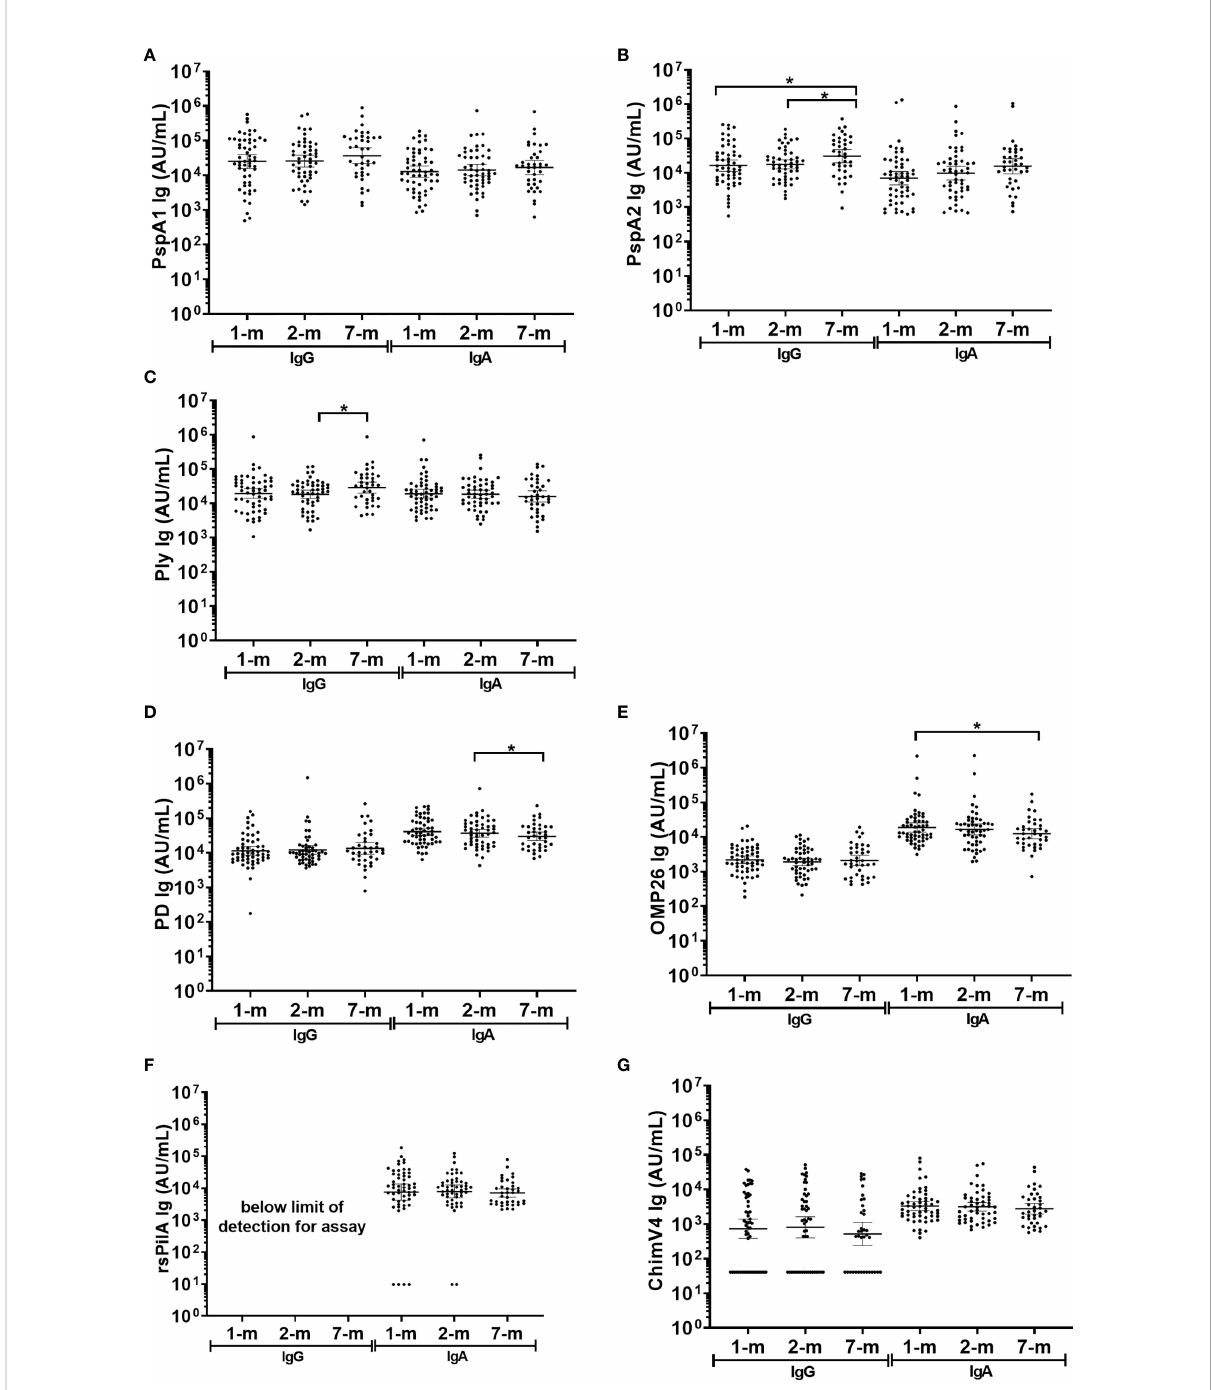
FIGURE 5 Breast milk IgG and IgA titres against Streptococcus pneumoniae and Haemophilus in fl uenzae antigens. Each point represents the breast milk IgG and IgA titres against S. pneumoniae antigens (A) PspA1, (B) PspA2, (C) Ply and H. in fl uenzae antigens (D) PD, (E) OMP26, (F) rsPilA and (G) ChimV4. PspA1, pneumococcal surface protein A family 1; PspA2, pneumococcal surface protein A family 2; Ply, pneumolysin. PD, Protein D; OMP26, outer membrane protein 26; rsPilA, recombinant soluble pilus A protein; ChimV4, chimeric vaccine antigen 4 (rsPilA and P5). * p-value <0.05, paired t-tested were conducted on the logarithmically transformed data. 1-month n=55, 2-months n=51, 7-months n=38. All samples had measurable antibody titres except for rsPilA, for which 6 samples were below the limit of detection for anti-rsPilA IgA. The assay reference breast milk had minimal rsPilA IgG therefore anti-rsPilA IgG titres could not be quanti fi